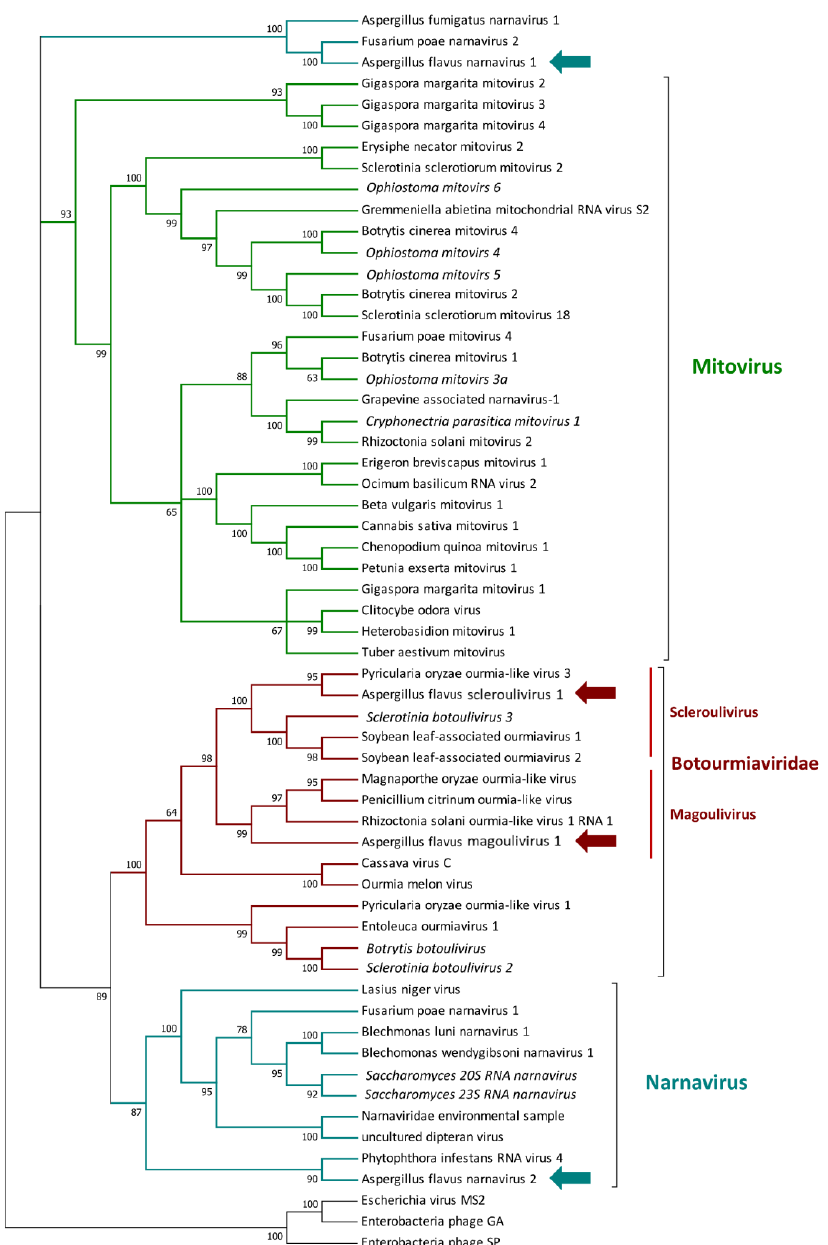
Figure 3. Phylogenetic relationship of viruses belonging to the Lenarviricota phylum. Amino acids’ sequences of RNA-dependent RNA polymerases (RdRps) were aligned using MUSCLE, and phylogeny were then derived using the likelihood methodology in IQTREE. Numbers above branches represent statistical support based on bootstrap analysis (1000 replicates). Viruses identified in this work are indicated by colored